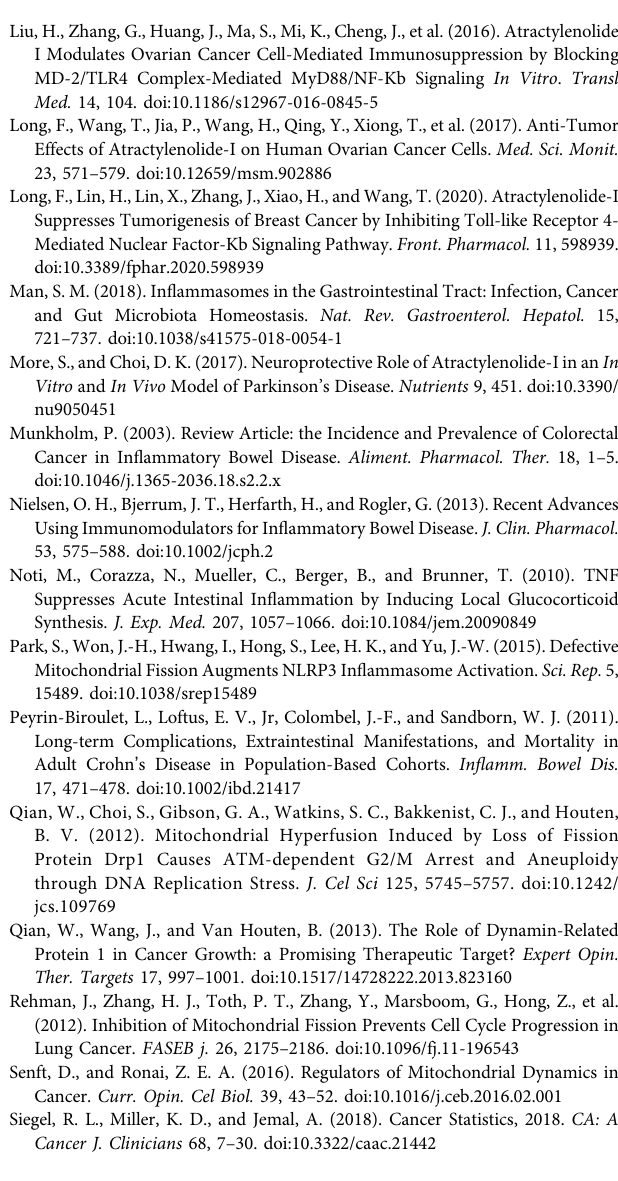
Supplementary Figure 1-4 | Histological study based on H&E staining (The original image of Figure 4A ). 1:Control, 2:Model, 3:ATR I 25 mg/kg/d, 4:ATR I 50 mg/kg/d. Supplementary Figure 5-8 | IHC of NLRP3 in colonic tissue section. Positive staining is brown (The original image of Figure 4C ). 5:Control, 6:Model, 7:ATR I 25 mg/kg/d, 8:ATR I 50 mg/kg/d. Supplementary Figure 9-12 | IHC of Drp1 in colonic tissue section. Positive staining is brown (The original image of Figure 5A ). 9:Control, 10:Model, 11:ATR I 25 mg/kg/d, 12:ATR I 50 mg/kg/d. Supplementary Figure 13-15 | TEM was applied to observe the morphology ofthe mitochondria (The original image of Figure 5C ). 13:Control, 14:Model, 15:ATR